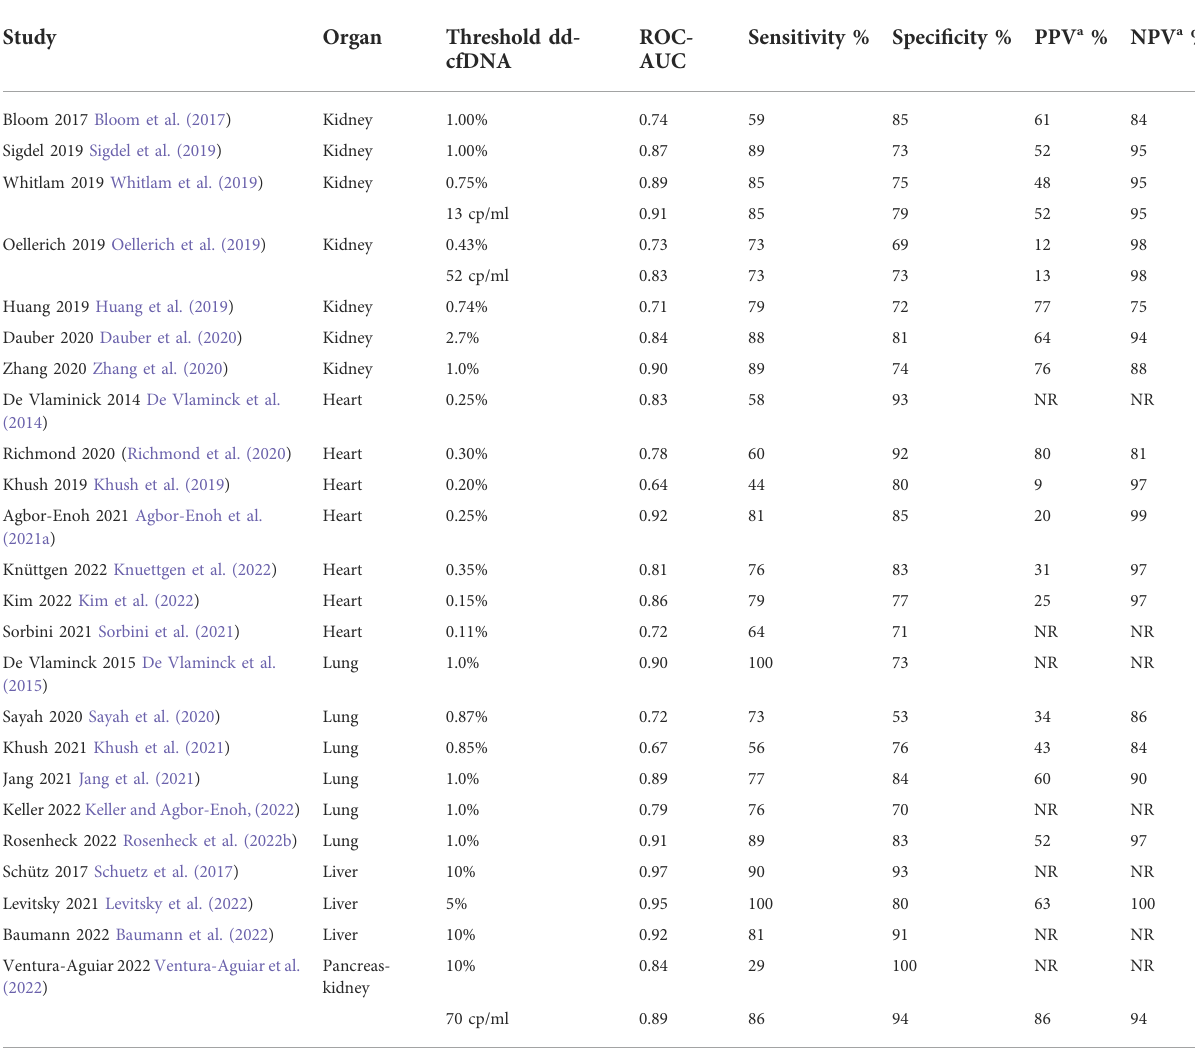
TABLE 2 Diagnostic performance of plasma dd-cfDNA for detection of rejection in solid organ transplantation.